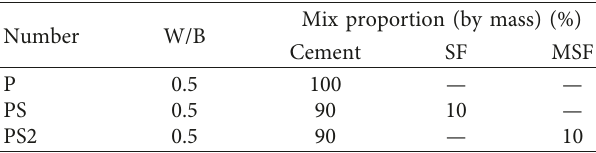
Table 4: The dosage of modification agent used in different samples (g).